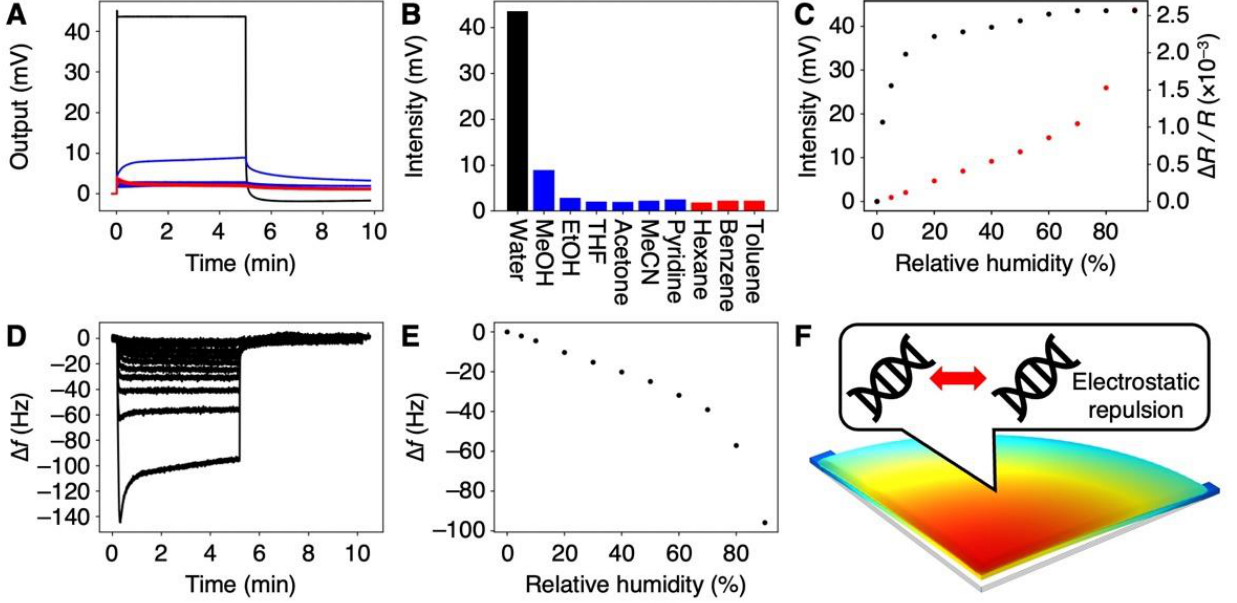
Figure 3. Moisture-selective response of the DNA-coated MSS. ( A ) Signal responses to various vapors at the concentration of P a / P o = 80%. Signal responses to all vapors; water (black), water-miscible organic solvents (blue), and water-immiscible organic solvents (red). All responses are shown in Figure S4. ( B ) Signal intensities for each vapor. ( C ) Humidity-dependent responses in the range of 0–80% RH (black). Red plots indicate the FEA results. ( D ) Frequency shifts of DNA-coated QCM in the range of 0–90%RH. ( E ) Frequency shifts of DNA-coated QCM as a function of relative humidity. ( F ) Plausible mechanism of hydration-induced electrostatic repulsion.